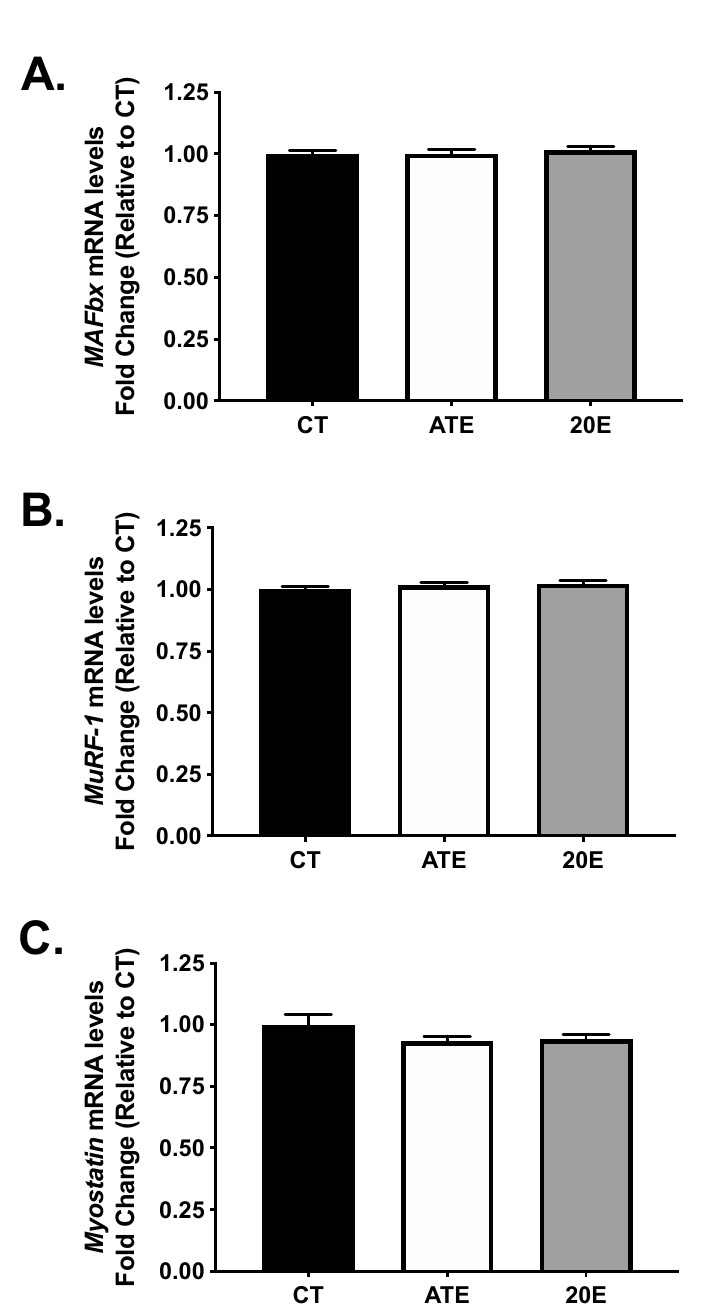
Figure 4. Analysis of mRNA levels for the atrogenes, MAFBx and MuRF-1 , and the negative regulator of muscle mass, myostatin in aging gastrocnemius muscle via real-time PCR after the 28-day supplementation period. Quantification of MAFBx ( A ), MuRF-1 ( B ), and myostatin ( C ) mRNA levels by treatment, respectively. Data are normalized to CT and presented as mean ± SEM. CT, control; ATE, A. turkestanica extract; 20E, 20-hydroxyecdysone. No significant differences were found, p > 0.05, all.